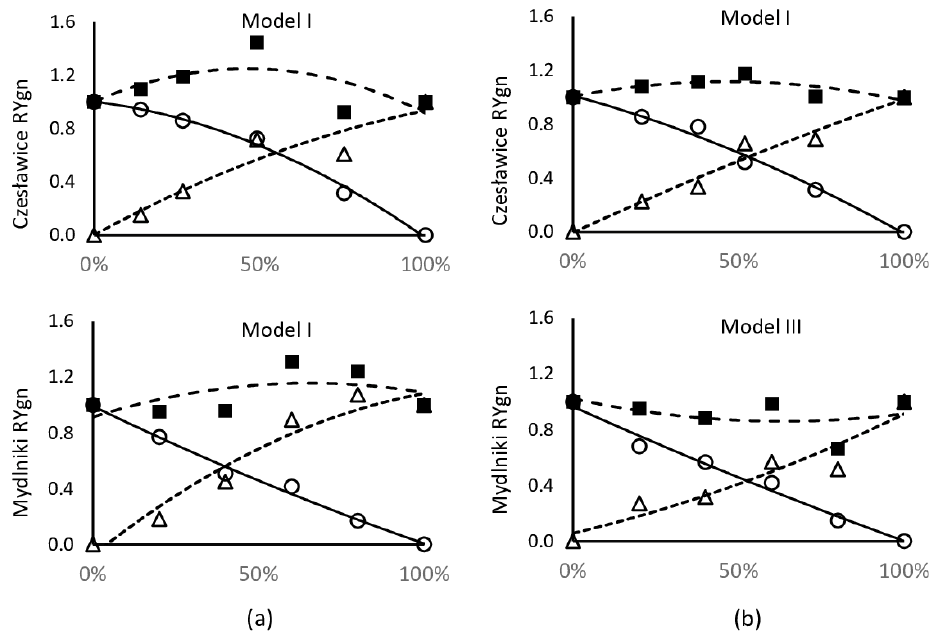
Figure 13. The replacement competition model for the relative seed number (RYse) of winter wheat and cornflower (B) in the 2019–2020 season, classified according to the t -test and p -values < 0.05. ( a ) competition between WW and B resistant (R) and ( b ) competition between WW and herbicide-susceptible cornflower (S). Legend: o—WW; ∆ —R ( a ) or S ( b ), □ —WW + R ( a ) or WW + S ( b ).